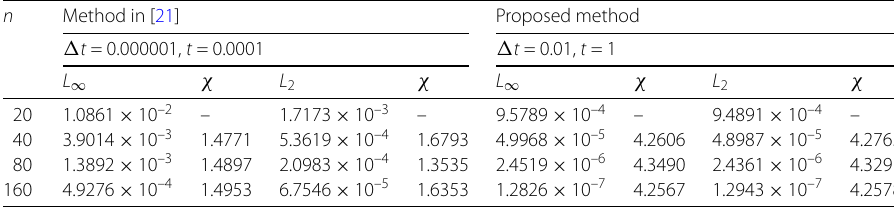
Table 4 Computational error norms and order of convergence for Problem 2 when γ = 0.5